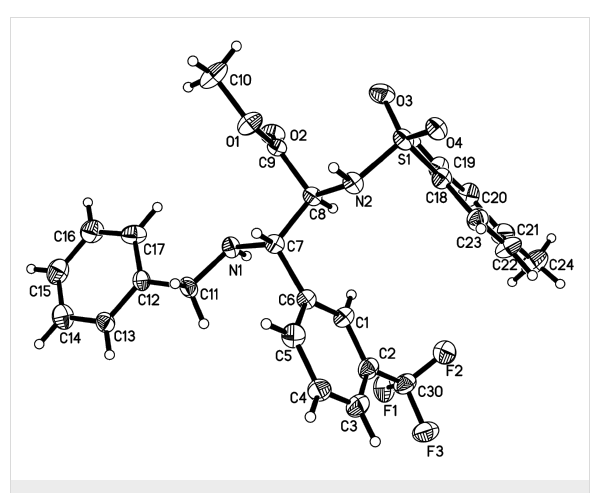
Figure 1: ORTEP diagram of compound 5o